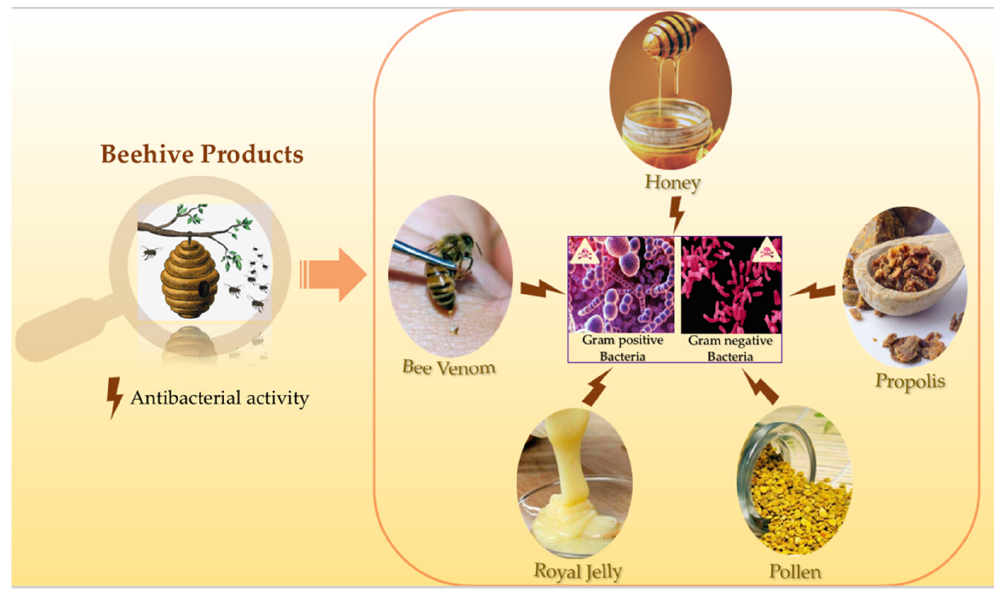
Figure 1. Schematic representation of the antibacterial properties of the beehive products.